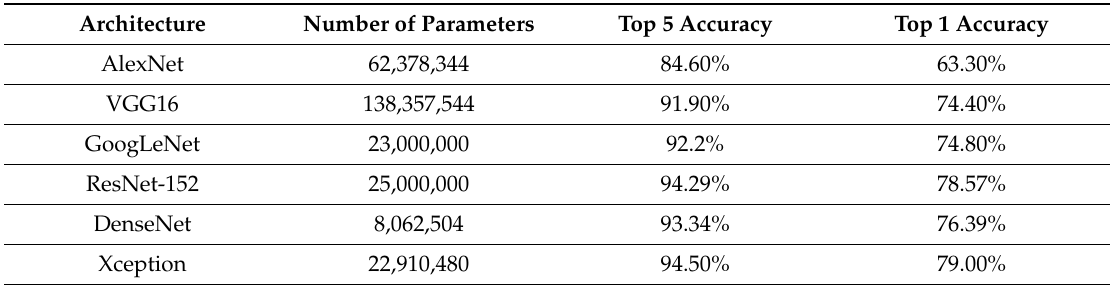
Table 1. Top 5 accuracy, top 1 accuracy, and the number of parameters of AlexNet, VGG, Inception, and ResNet in the ImageNet Large Scale Visual Recognition Challenge (ILSVRC)